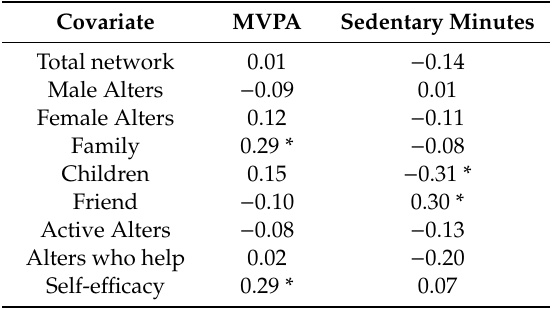
Table 3. Pearson correlation coe ffi cient for associations between network composition and minutes of Moderate-to-Vigorous Physical Activity (MVPA) and sedentary